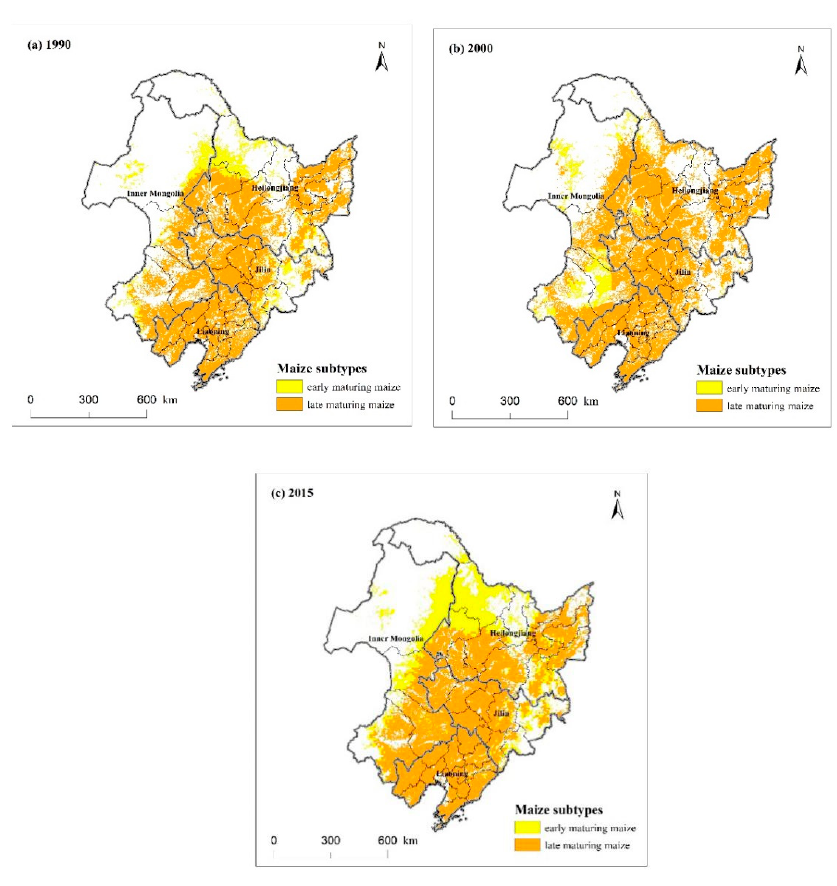
Figure 8. Maize potential subtypes changes from 1990 to 2015. ( a ) 1990; ( b ) 2000; ( c ) 2015. Int. J. Environ. Res. Public Health 2019 , 16 , x From 2000 to 2015, the mean temperature of all stations increased (Figure 9a). Except Fujin and Hulin in NEA, Mudanjiang in EA, and Harbin in CA, the total precipitation of other stations increased (Figure 9b). The total sunshine duration decreased in most stations, except Hulin in NEA and Wafangdian in SA (Figure 9c). In CA, the main reasons that maize potential yield increased by more than 1000 kg/ha were that climate warming promoted maize growth and sufficient precipitation and irrigation ensured the absorption of water. However, the decrease of maize potential yield elsewhere and Harbin in CA was mainly because of inadequate rainfall or solar radiation.